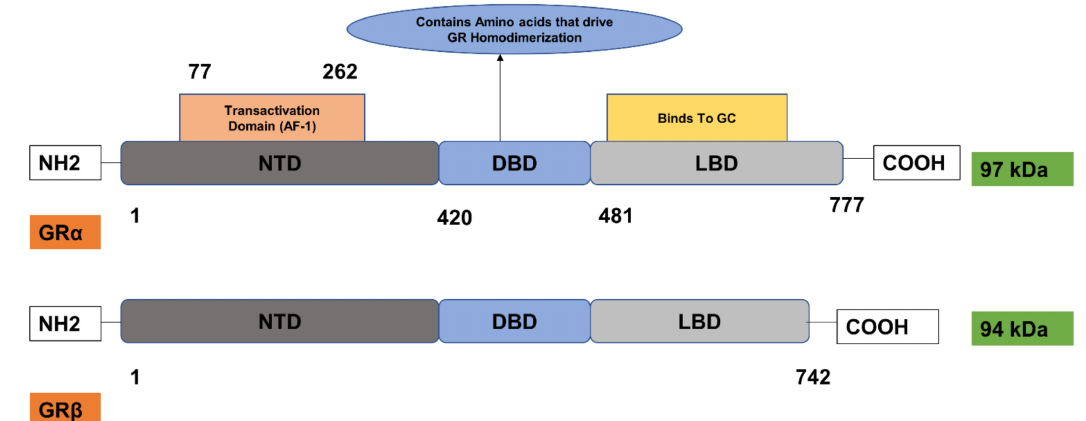
Figure 5. Glucocorticoid receptor α and β isoforms. Alternative splicing of the human glucocorticoid receptor gene (hGR) in exon 9, results in two receptor isoforms GR α and β , which differ at the ends of their C-termini by the number of amino acids in the ligand-binding domain (LBD). The three major domains of the hGR are N-terminal domain (NTD), DNA-binding domain (DBD) and ligand-binding domain (LBD). The N-terminal domain contains a major transactivation domain called Activation Factor-1 (AF-1), critical for the transcriptional activation of the receptor. DNA-binding domain (DBD) contains amino acids responsible for GR homodimerisation. The LBD consists of the ligand-binding site. GR α contains 50 additional amino acids in its ligand-binding domain (LBD) with a molecular weight of 97 kDa and GR β contains 15 amino acids with a molecular weight of 94 kDa. Of the two isoforms, only GR α binds to the glucocorticoids. Adapted from [109].